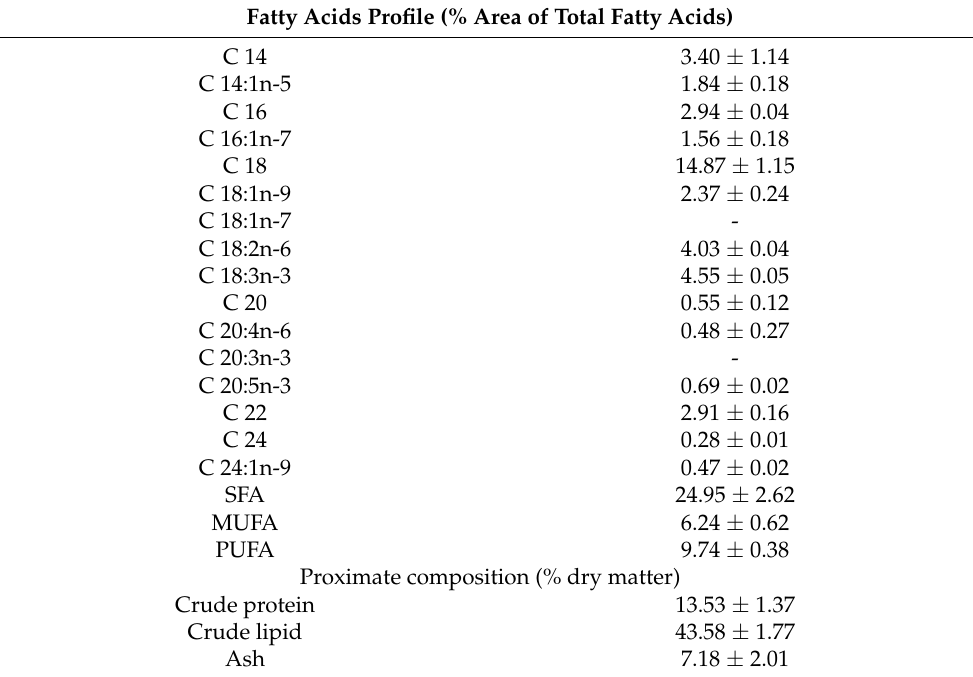
Table 1. Fatty-acid profile and proximate composition of Haematococcus sp. used to feed B. orientalis . Fatty Acids Profile (% Area of Total Fatty